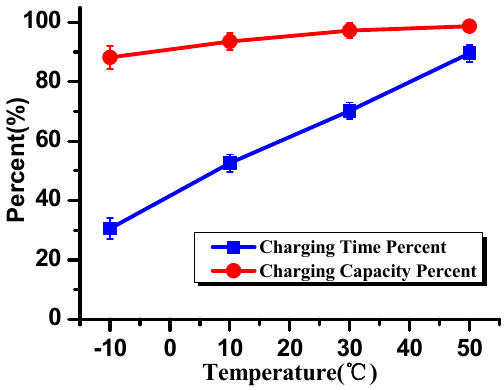
Figure 3. Charging time percentage and charging capacity percentage between CC strategy and CC/CV strategy at different charging current rates.